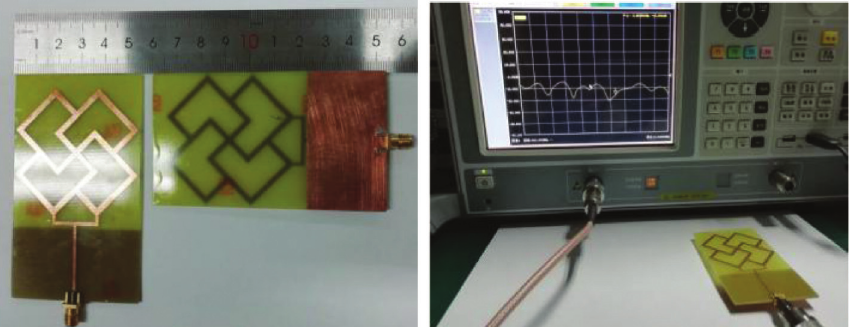
Figure 16: The prototype of a microstrip antenna with a cross structure imitating classical grilles and a vector network analyzer test